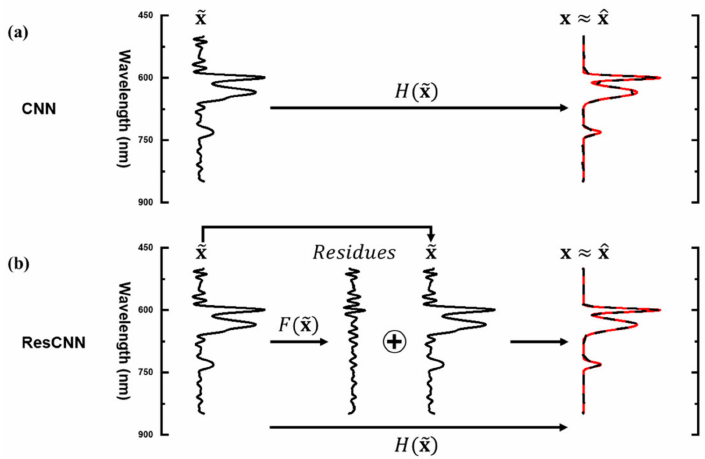
Figure 3. Descriptions of the spectrum recovery process: ( a ) convolutional neural network (CNN), ( b )